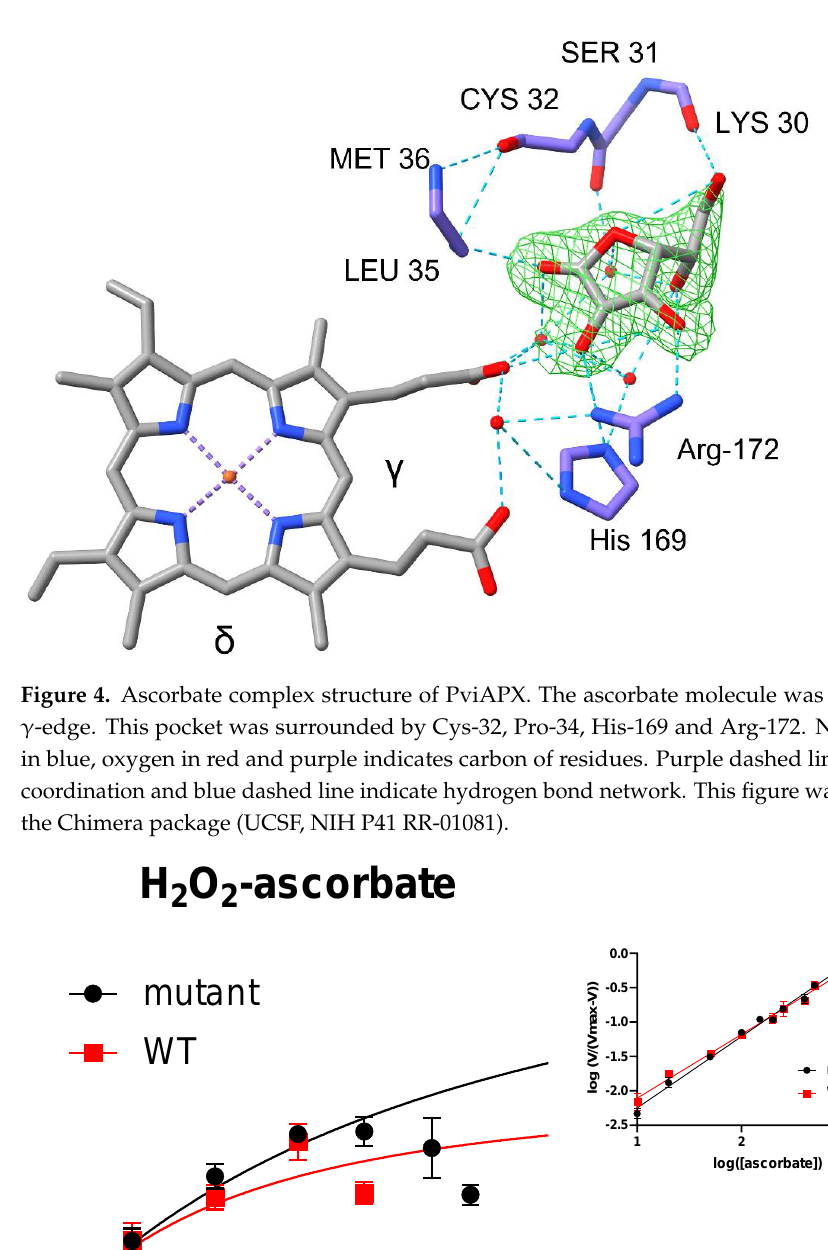
positive cooperativity of multiple binding sites [11,50].